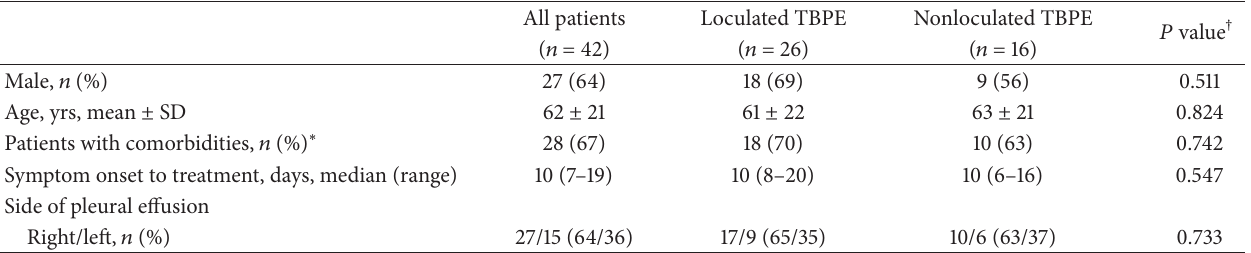
Table 1: Demographic and clinical data of the patients studied.